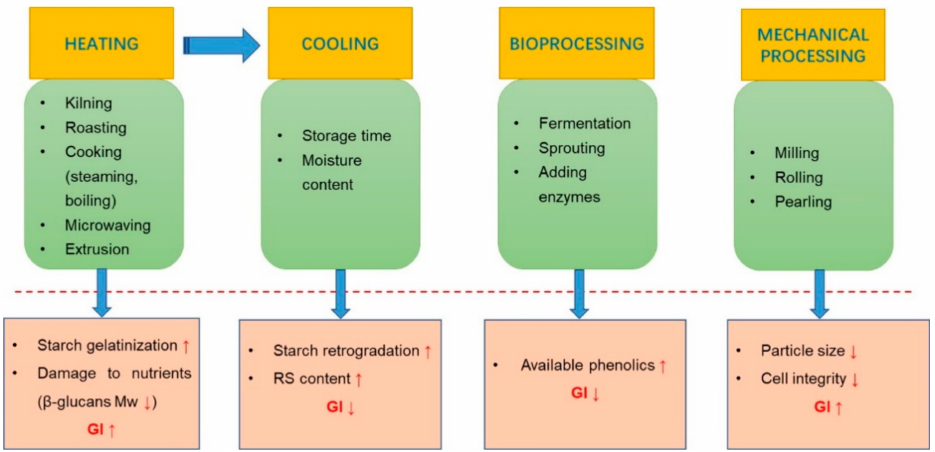
Figure 3. The overview of the effects of representative processing techniques on GI and possible mech-